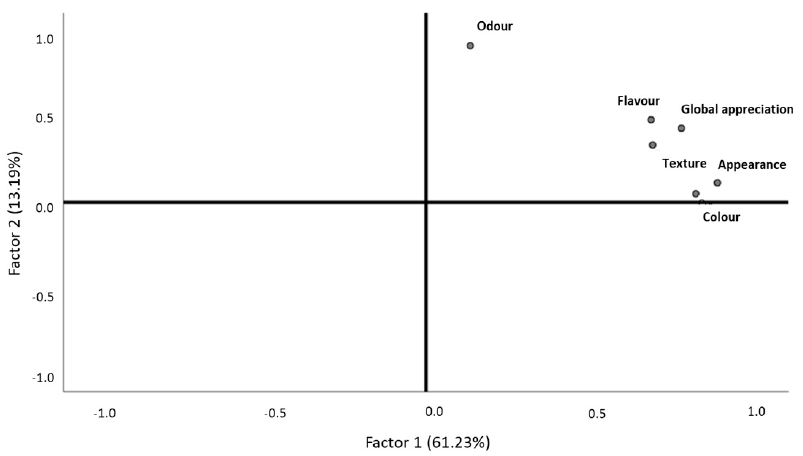
Figure 11. Behavior of smoked blue jack mackerel pâté descriptors, according to consumer classifi- cations. Table 9. Rotated component matrix for each smoked blue jack mackerel pâté descriptor.